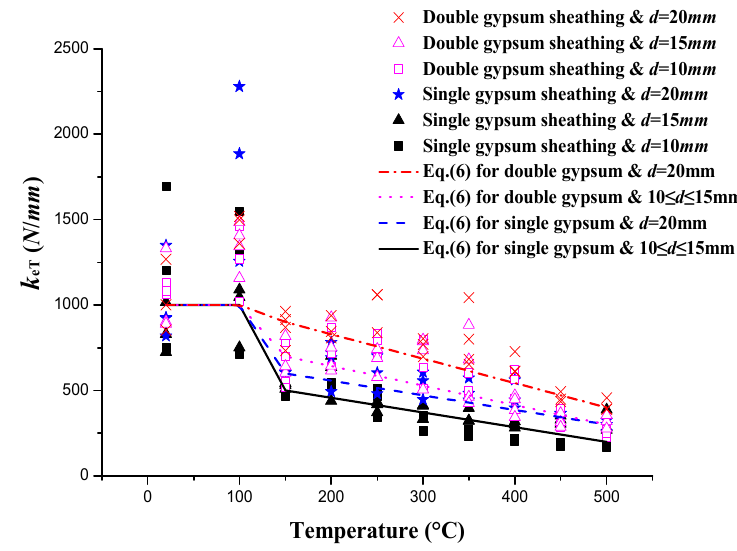
Figure 15. Predicted initial stiffness compared to the experimental results.